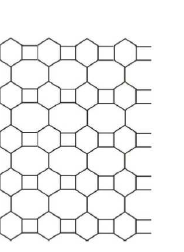
Figure 3. The 2-D graph lattice of T UC 4 C 6 C 8 [4 , 5] nanotube.